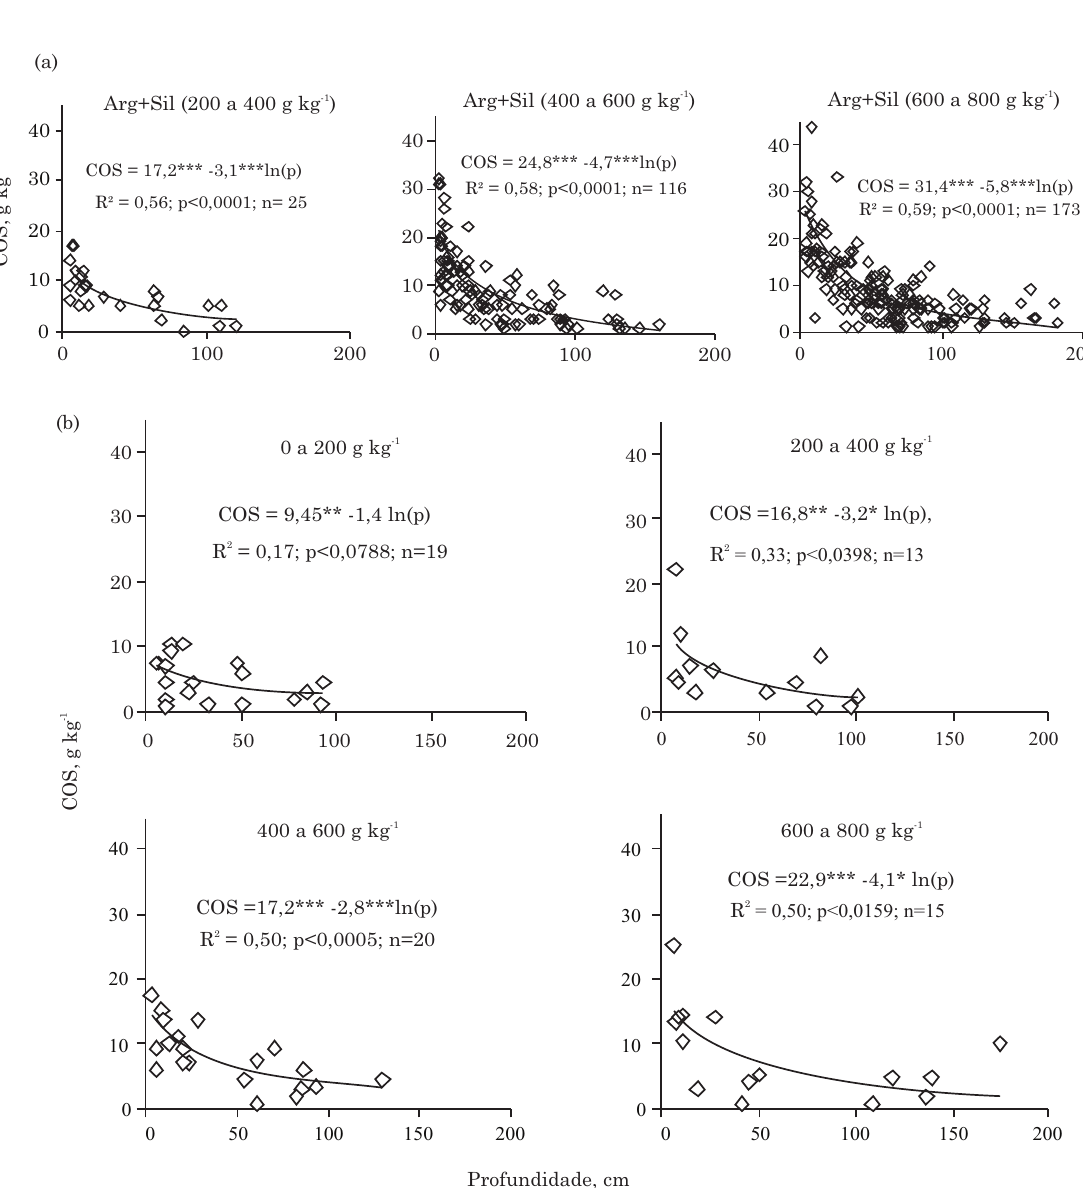
Figura 4. Perfis de COS para as principais classes de teor de argila+silte: a) região Sul; e b) Serra do Espinhaço Meridional, MG. O nível de significância para os parâmetros intercepto e fator logarítmico é representado por *,** e ***, respectivamente, para p<0,05, p<0,01 e